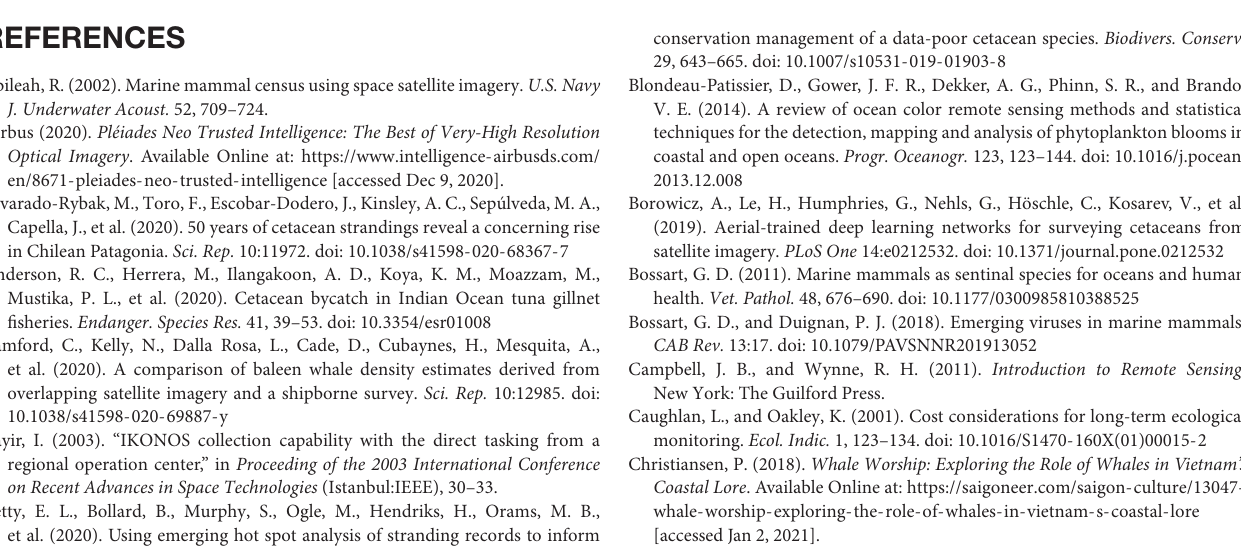
Supplementary Figure 1 | A map showing human population density (people per sq. km of land area) by country (human population density data accessed from the World Bank using: HYPERLINK https://data.worldbank.org/indicator/EN.POP. DNST?end=2019&start=1961&type=points&view=chart&year=2019 and the world map country polygon shapefile accessed using: https://hub.arcgis.com/data sets/UIA::countries-wgs84?geometry=11.250%2C-89.998%2C-11.250%2C-79.